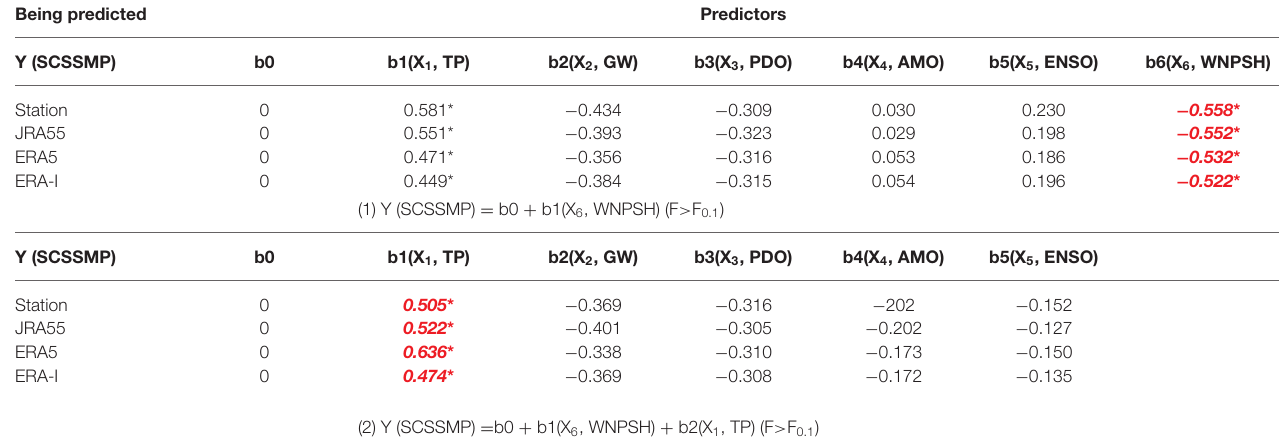
TABLE 2 | Picking out the main factors affected SCSSM precipitation by using stepwise regression method. Being predicted